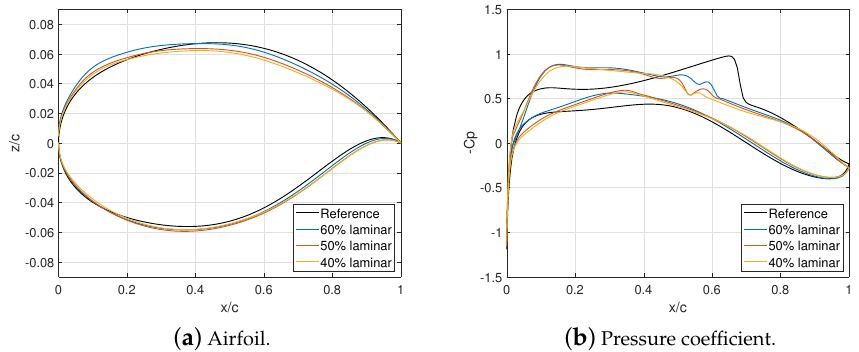
Figure 20. Backward-swept wing section for the optimised configuration with n max =